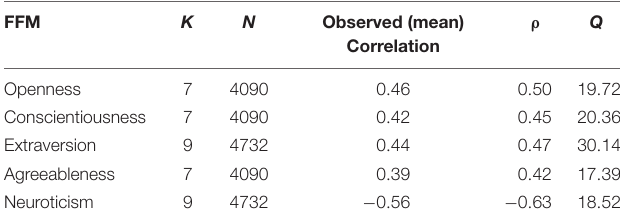
TABLE 1 | Meta-analytic correlations between the Big Five and ego-resilience as reported in Oshio et al. (2018). FFM K N Observed (mean)